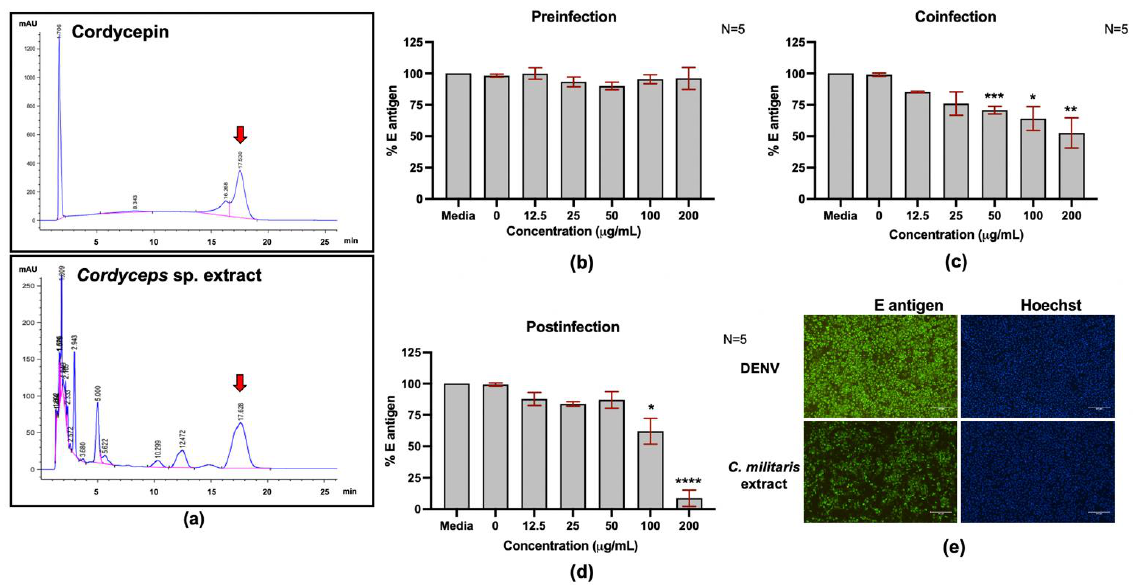
Figure 6. High-performance liquid chromatography (HPLC) profiles of cordycepin and Cordyceps militaris extract, and the anti-DENV2 activity of C. militaris extract in DENV2-infected Vero cells. ( a ) HPLC profiles of cordycepin (upper panel) and C. militaris extract (lower panel). ( b – d ) Anti-DENV2 activity of C. militaris extract in DENV2-infected Vero cells ( b ) before (preinfection), ( c ) during (coinfection), and ( d ) after (postinfection) DENV2 infection. ( e ) The DENV2 envelope (E) protein was detected 48 h postinfection by immunofluorescence assay (IFA). (* indicates p < 0.05; ** indicates p < 0.01; *** indicates p < 0.001, and **** indicates p < 0.0001.)